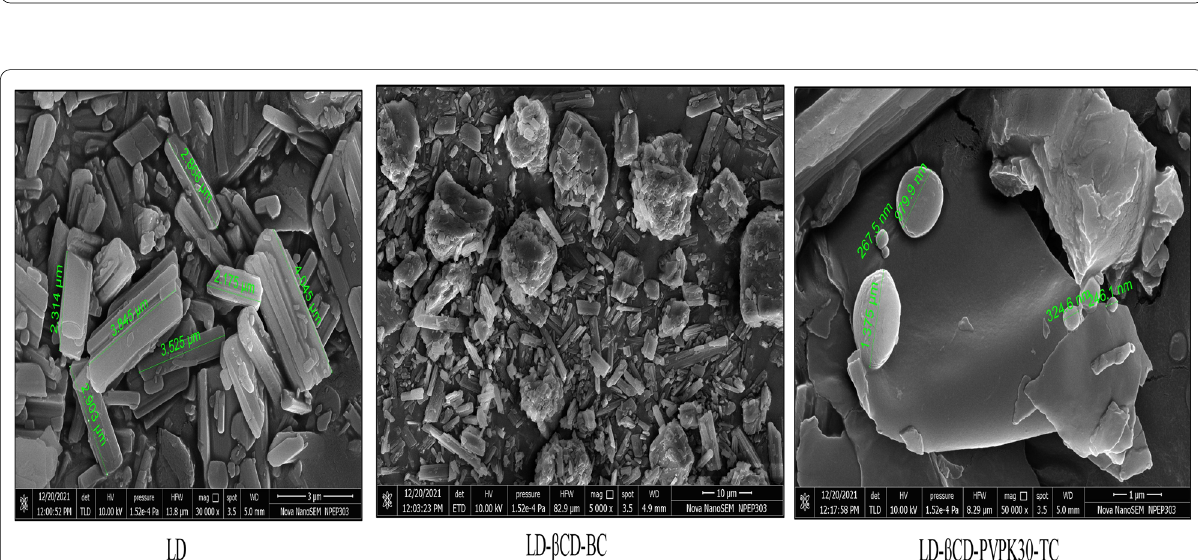
Fig. 11 SEM Photomicrographs of Lapatinib ditosylate and its binary and ternary formulations, LD-βCD-BC,